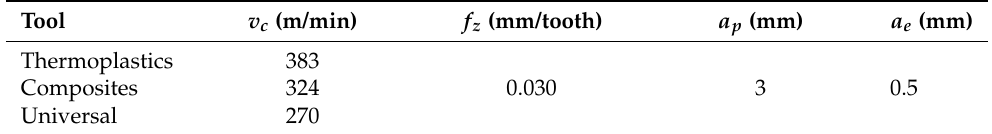
Table 2. Starting parameters for each tool.